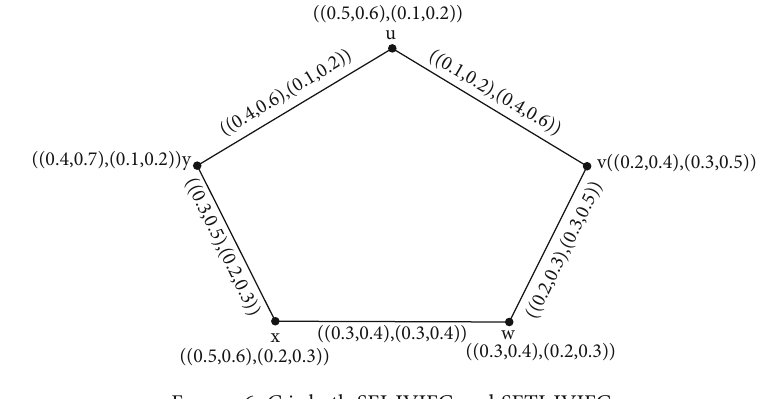
Figure 6: G is both SEI-IVIFG and SETI-IVIFG.